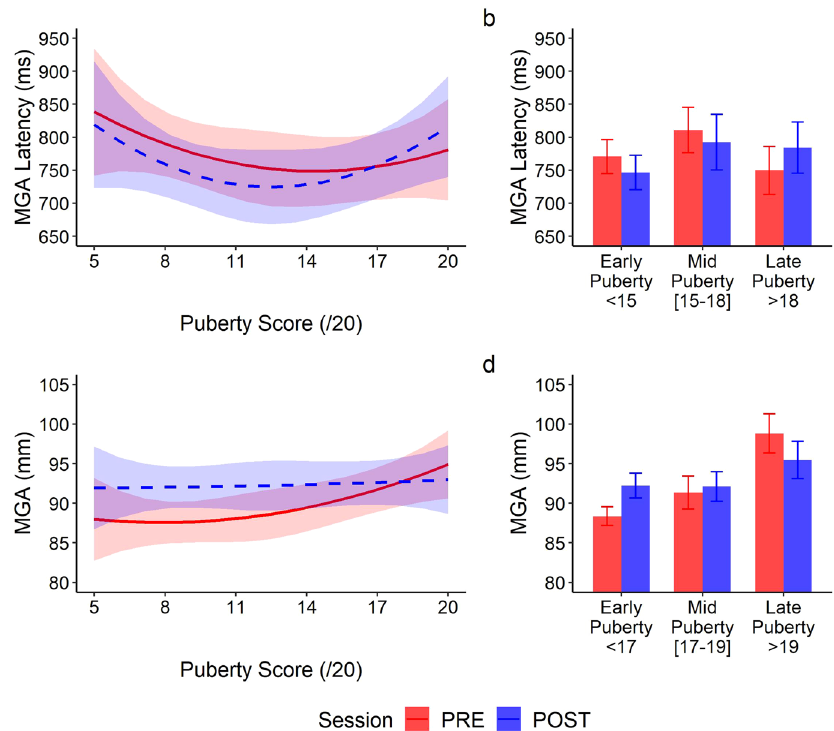
Figure 4. Evolution of the kinematics of the Grasping component of the movement before (solid red) and after (dashed blue) tool use, as a function of the puberty score. Panels a and c are representative illustrations of the polynomial fit of the data for the Maximum Grip Aperture latency ( a ) and its amplitude ( c ), with the 95% confidence interval indicated by colored areas. ( a ) After tool-use early puberty participants displayed shorter MGA latency (blue line with respect to the red line); beyond mid puberty, participants reversed their kinematics patterns and displayed longer latencies after tool use. ( c ) A pattern reversal was also observed for the finger aperture, with less difference with development. For better visualization, panels ( b ) and ( d ) report three groups we computed for the same parameters based on the puberty score, the mid-puberty group being the one for which no significant modification was observed between PRE and POST in the model (cut-off scores differing for each parameter, see section “Crossing Point” below). Here we clearly see that differences between PRE and POST are still present in the late adolescent group, at odds with what is usually observed in adults. Error bars indicate the means ± 1 sem.